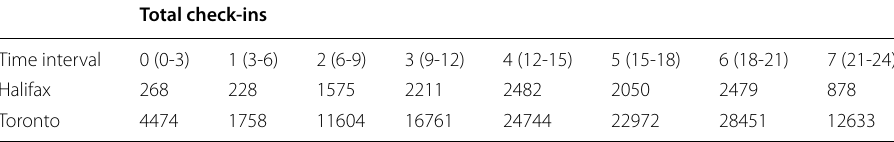
Table 3 Total check-ins for each time interval Total